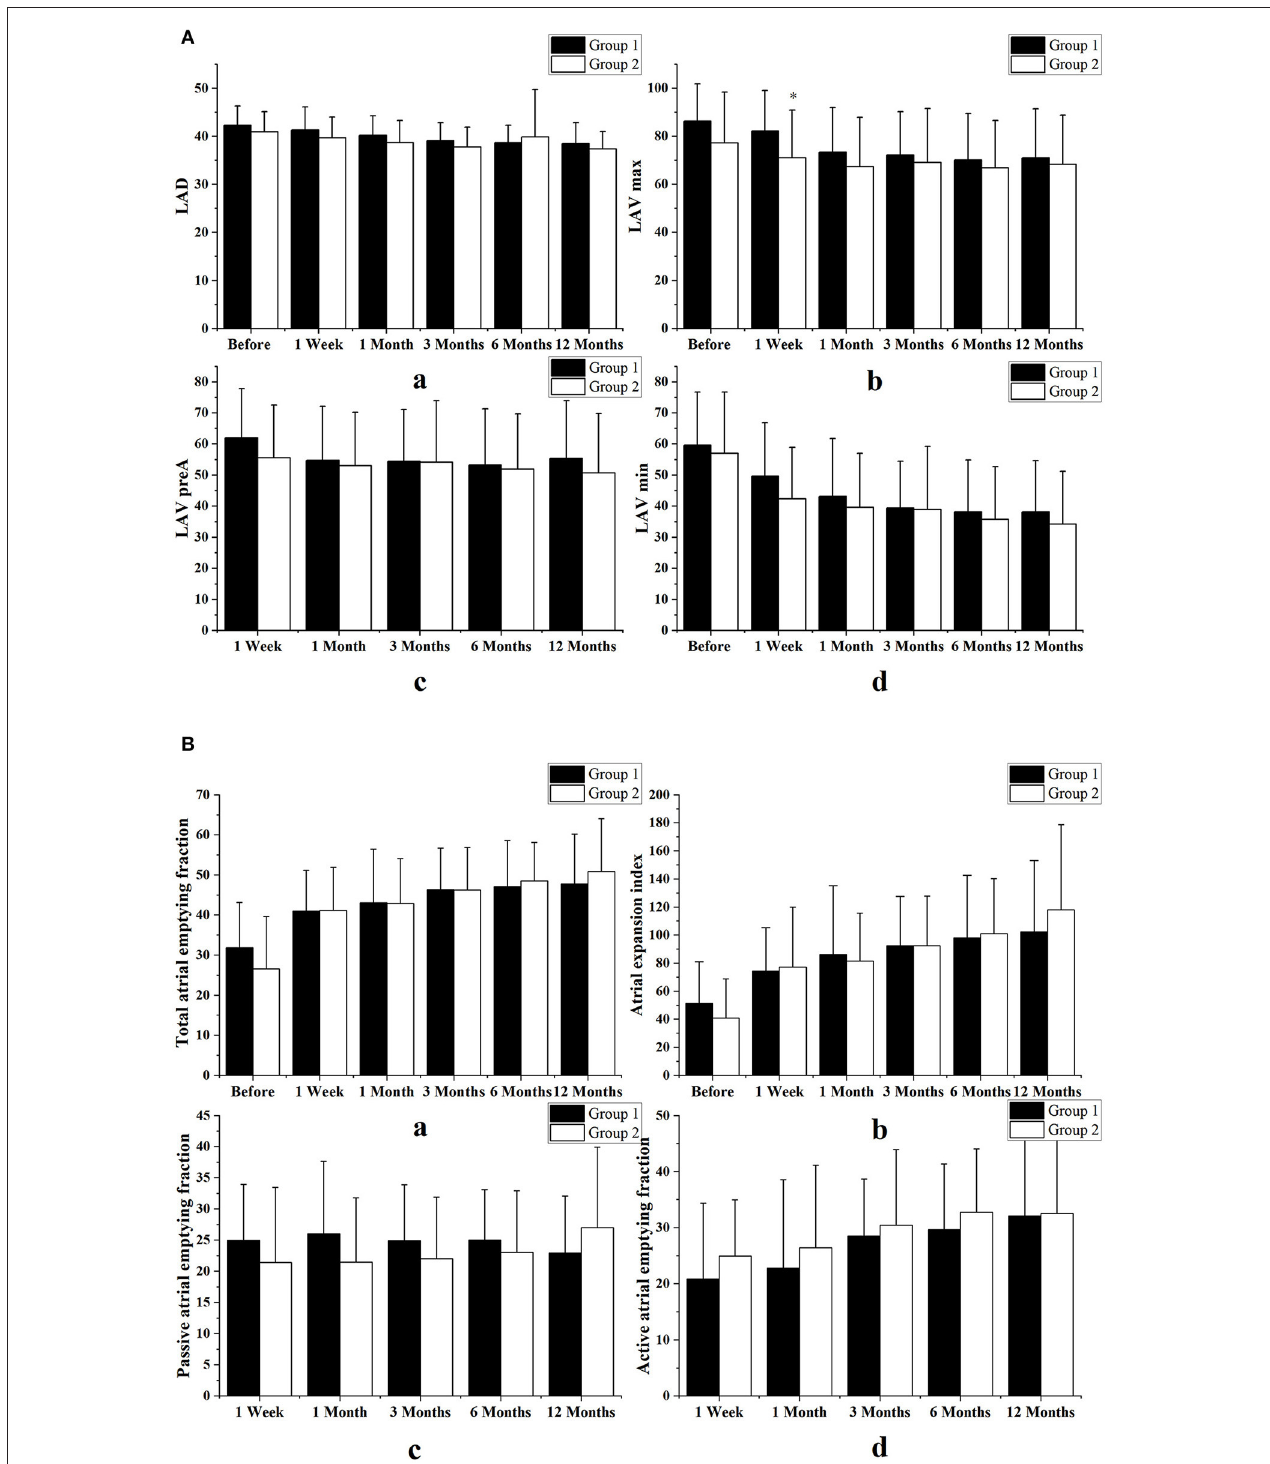
FIGURE 4 | Comparisons of the LA diameter volumes and function in the two groups as assessed by volumetric indices. (A) Comparison of left atrial diameter (LAD) and volume (LAV) between the combined therapy group (Group 1) and those who underwent simple ablation group (Group 2). (B) Comparison of atrial function, as assessed by volumetric indices, between the two groups. We found no differences in left atrial diameters, left atrial volumes, left atrial total emptying fractions, expansion indices, or passive or active emptying fractions. Variables are expressed as means ± standard deviations. * p < 0.05 vs. the combined therapy group at the same follow-up